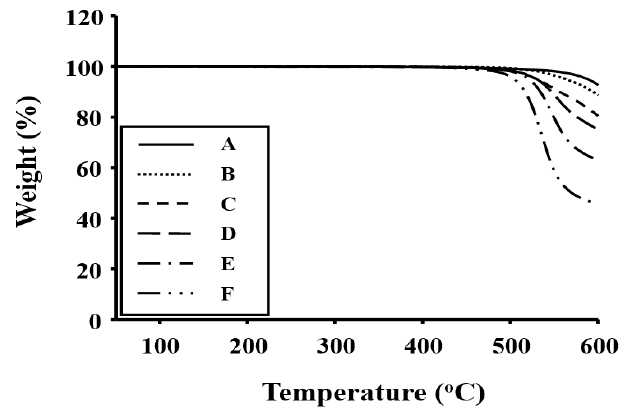
Figure 1. Thermogravimetric analysis (TGA) thermograms of the Co-PI films.